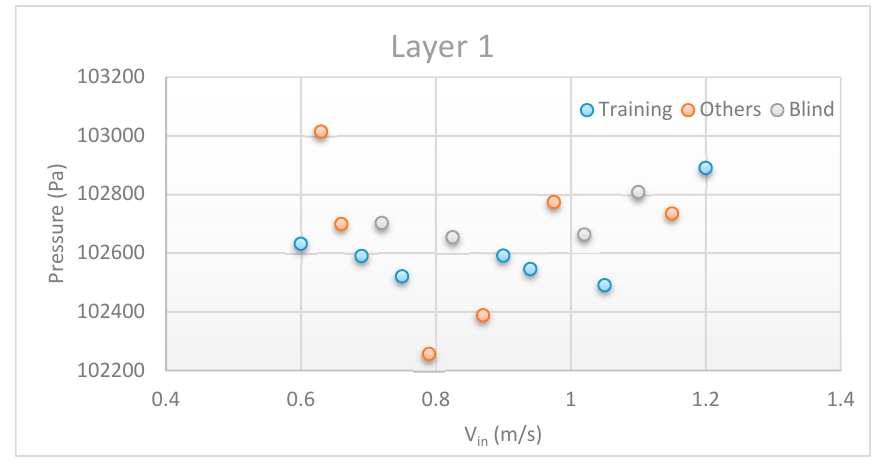
ff erent inlet velocities.